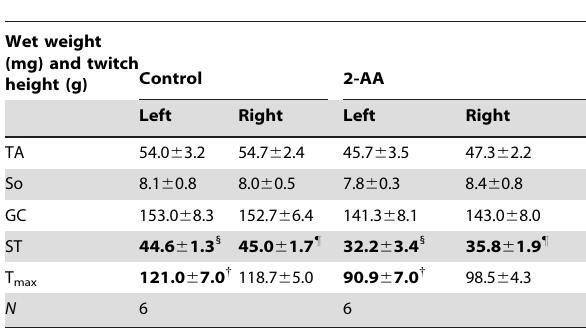
Figure 7. Schematic model for 2-AA mediated molecular mechanisms of mitochondrial dysfunction in skeletal muscle. 2-AA triggers mitochondrial dysfunction via the down-regulation of peroxisome proliferative activated receptor, gamma, coactivator (PGC)- 1 b , peroxisome proliferator activated receptor (PPAR)- c , sirtuin (Sirt)-1, the insulin signaling pathway, overall energy metabolism, and increased lipid accumulation.